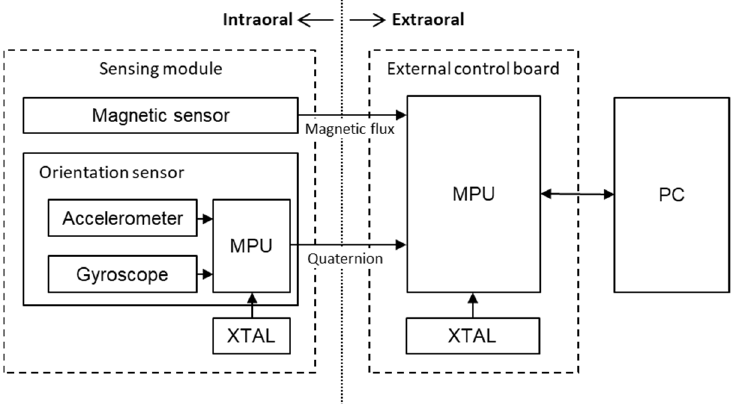
Figure 5. Block diagram of the tracking system. MPU, memory protection unit; XTAL, crystal; PC, personal computer.